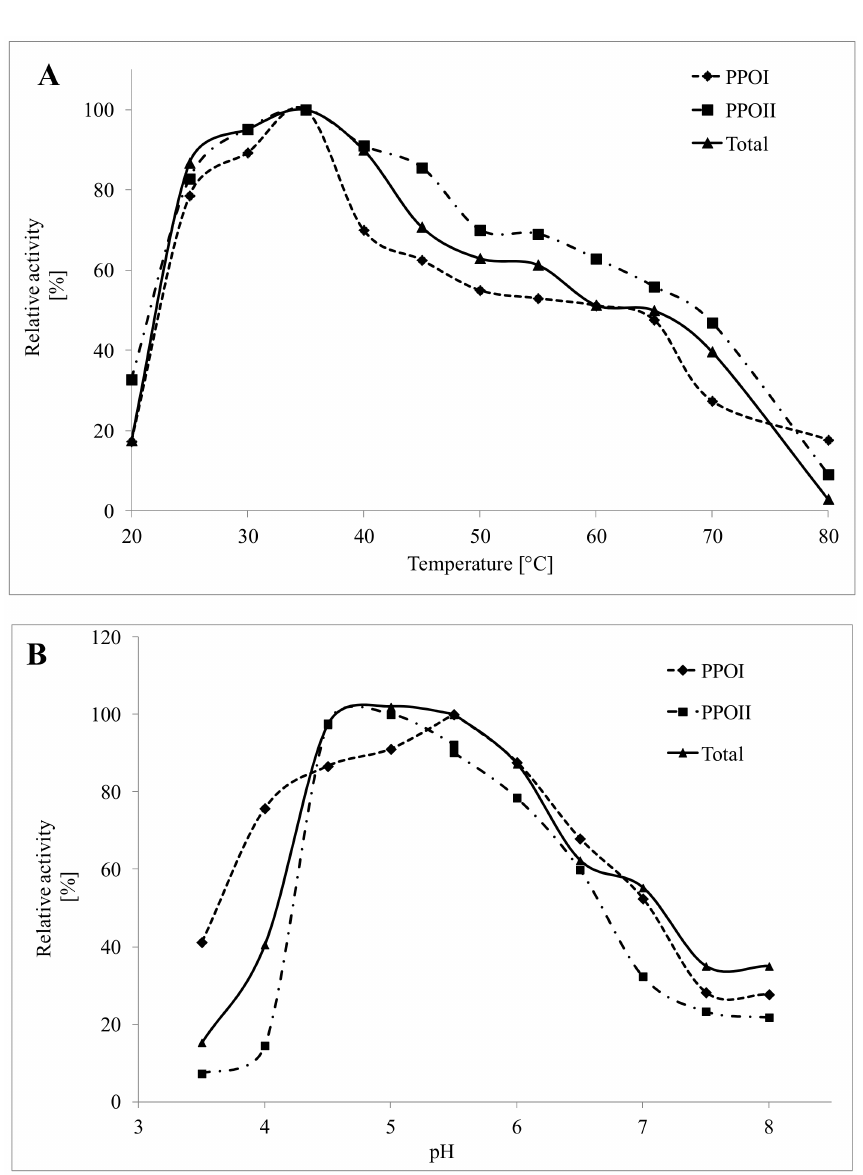
Figure 2. E ff ects of temperature ( A ) and pH ( B ) on the activity of lentil sprout